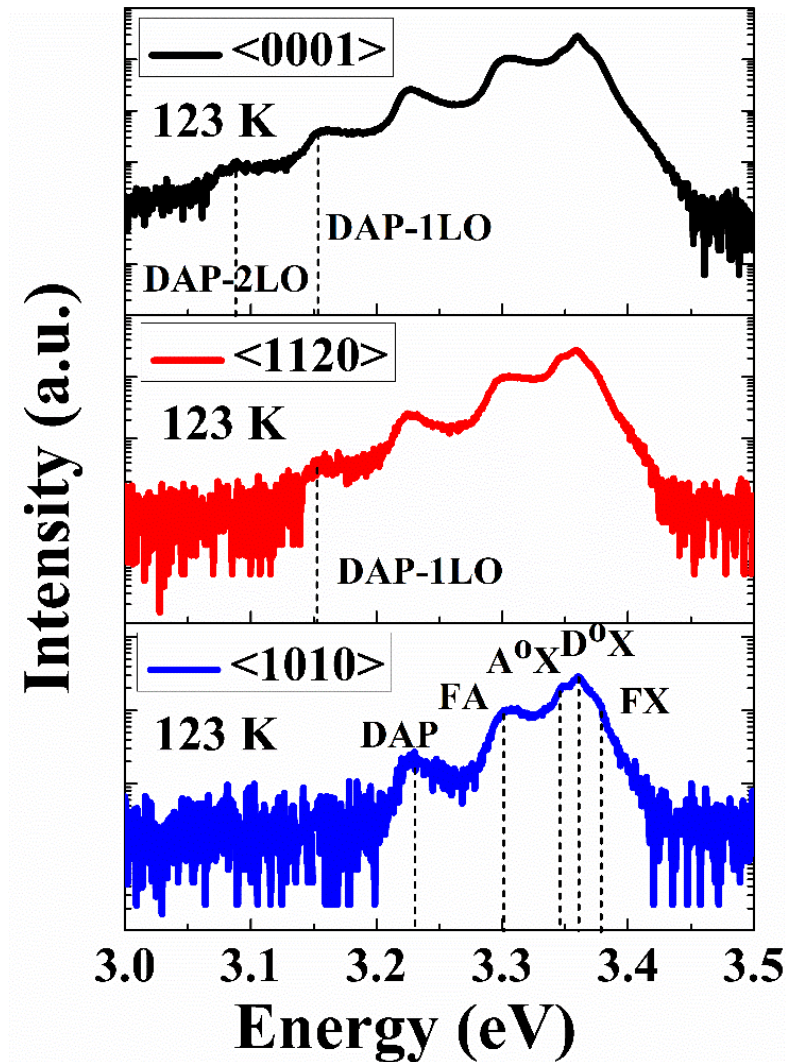
Figure 7. Low-temperature PL spectra of ZnO single crystals having three different orientations.